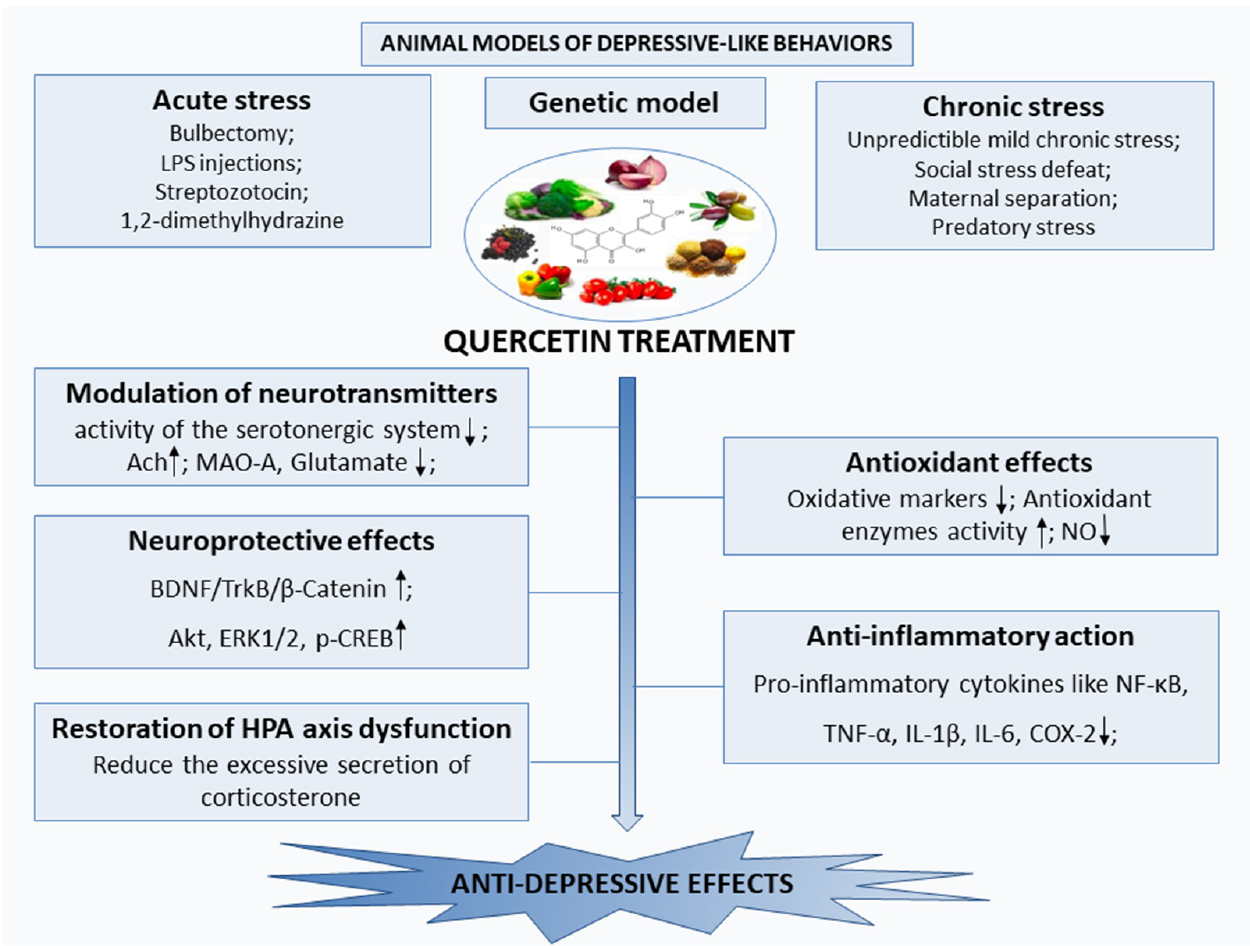
Figure 4. The image graphically summarizes the main mechanisms of action proposed to mediate the antidepressive effects of quercetin. The image of quercetin was created using PubChem (https://pubchem.ncbi.nlm.nih.gov/edit3/index.html/, accessed on 21 June 2021). Ach, acetylcholine; MAO-A, monoamine oxidase-A; NO, nitric oxide; BDNF, brain-derived neutrophic factor; TrkB, tropomyosin receptor kinase B; Akt, protein kinase B; ERK1/2, extracellular regulatory protein kinase1/2; NF- κ B, nuclear factor- κ B; TNF- α , tumor necrosis factor- α ; IL, interleukin; COX-2, Cyclooxygenase-2;